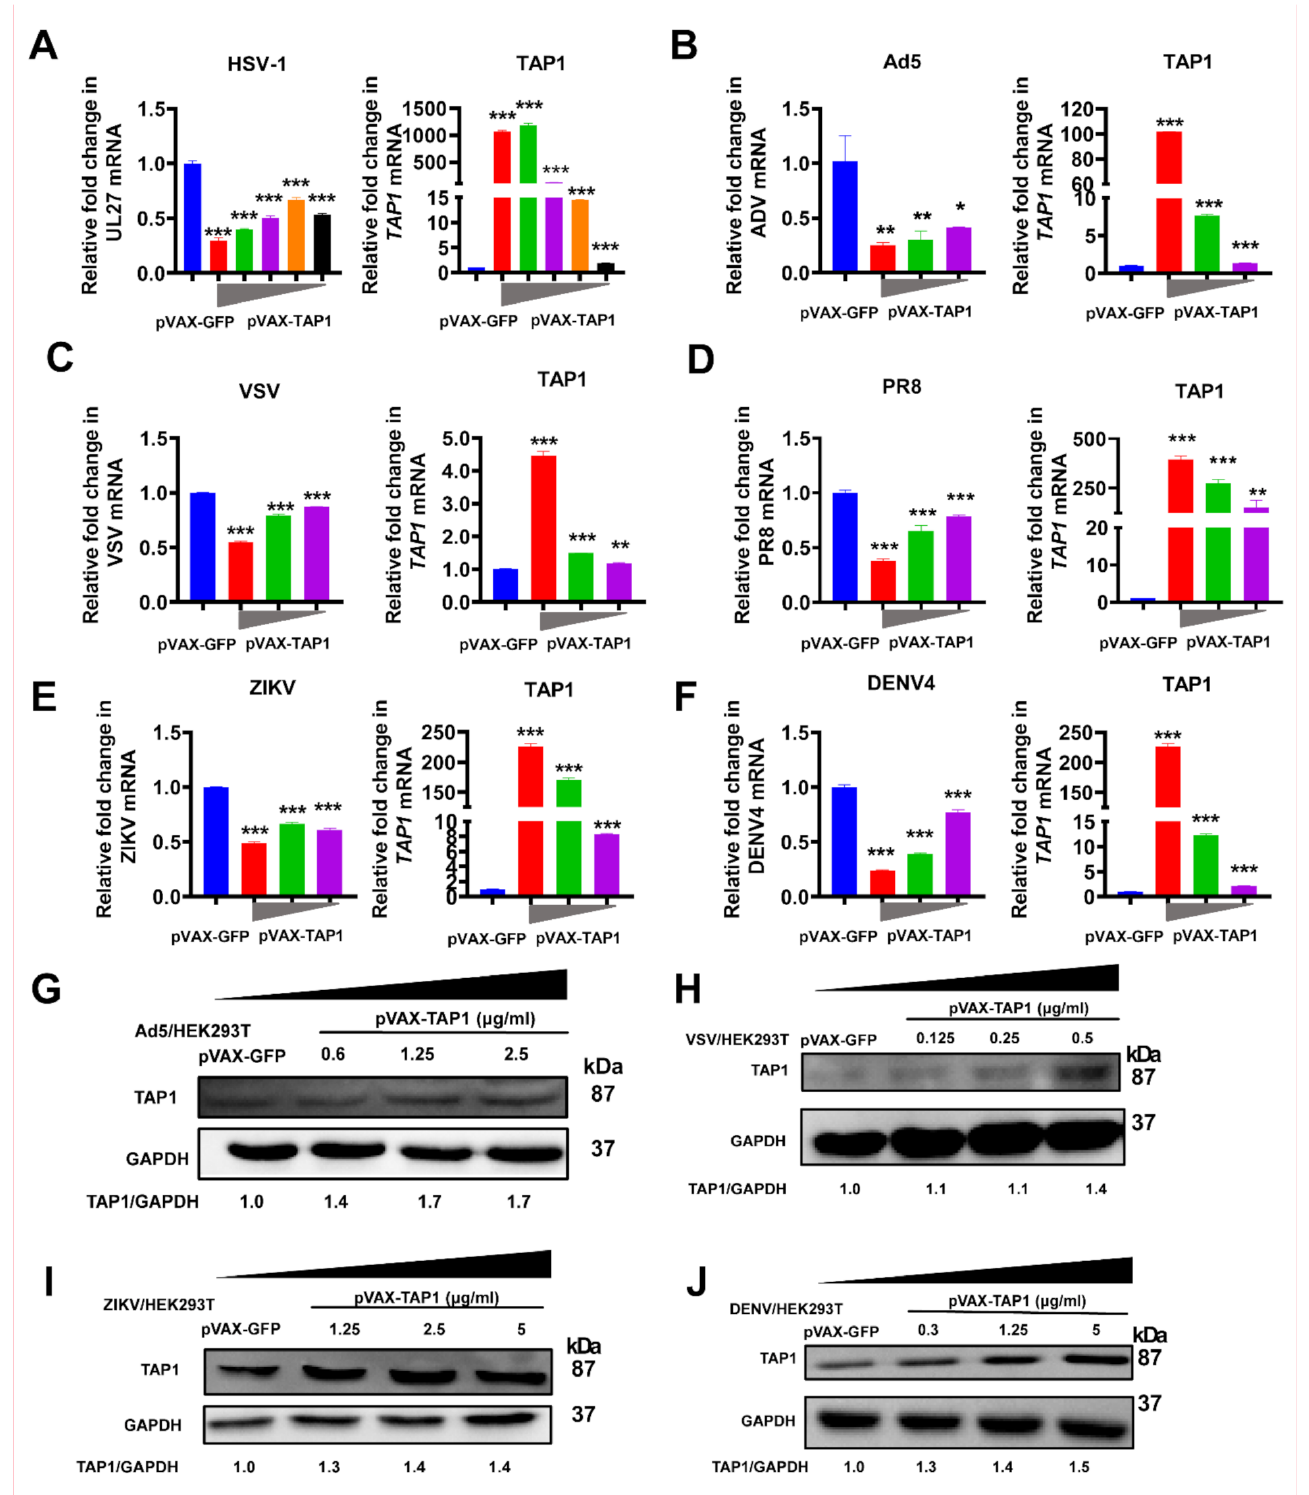
Figure 2. Broadly antiviral activities of TAP1. ( A ) HEK293T cells were transfected with TAP1 -expressing plasmid in different concentrations (2.5 µ g/mL, 1.25 µ g/mL, 0.6 µ g/mL, and 0.3 µ g/mL) for 24 h, followed by HSV-1 infection (MOI = 1)